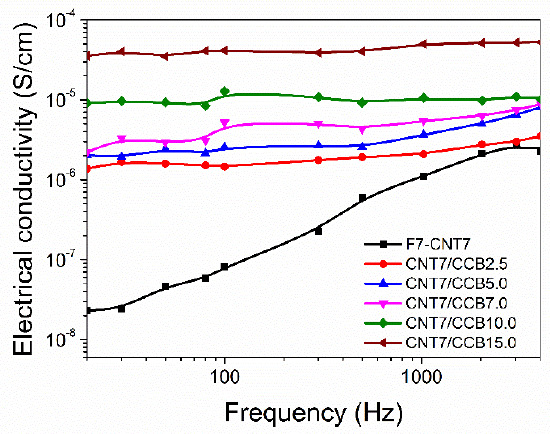
Figure 9. Electrical conductivity as a function of frequency of ENR-FeCl 3 filled with CNTs (F7-CNT7) and CNT-CCB hybrid filler with various CCB loadings at 2.5, 5.0, 7.0, 10.0 and 15.0 phr.